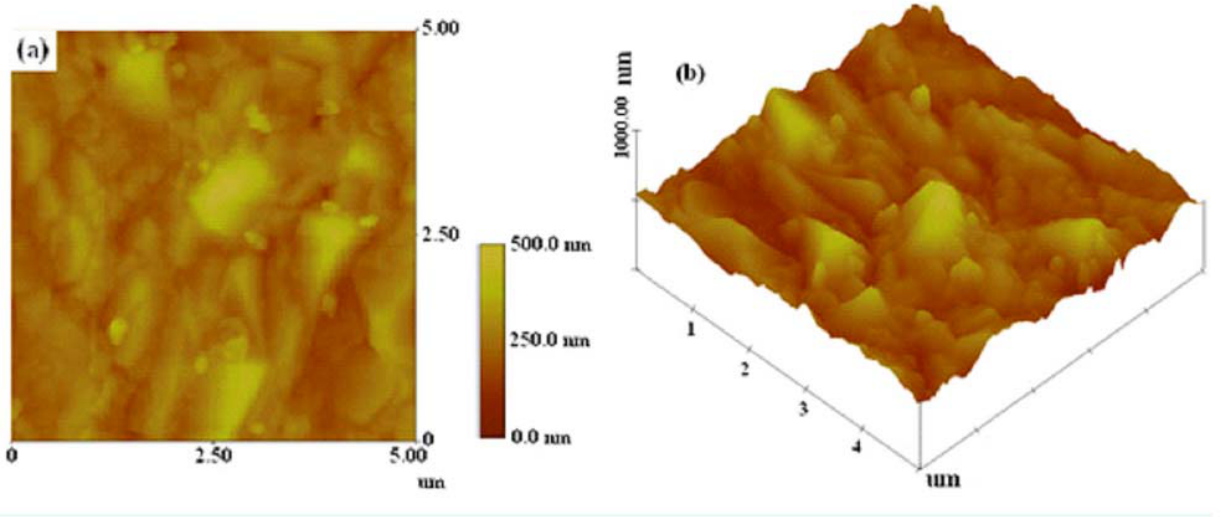
Figure 2. Atomic force microscopy images of a mercury (2 mM)/gold